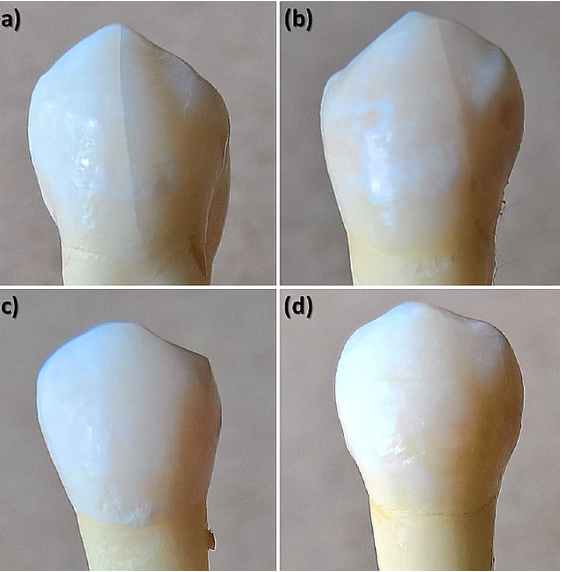
Figure 2. An example of photographs of teeth with ( a , b ) visible and ( c , d ) invisible EMCs on the outer buccal tooth surface (adapted from 20 ).